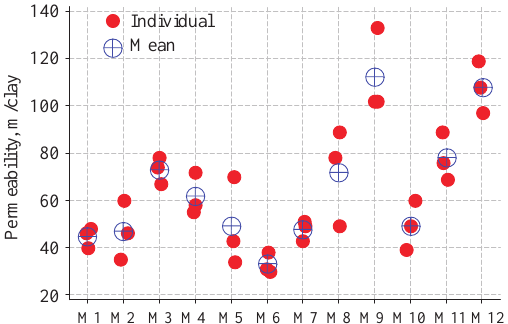
Fig. 5. Results of permeability tests on all 12 mixes